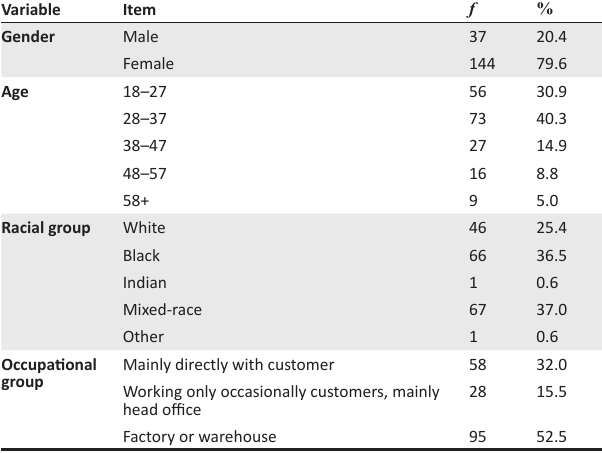
TABLE 1: Characteristics of respondents ( n = 181).